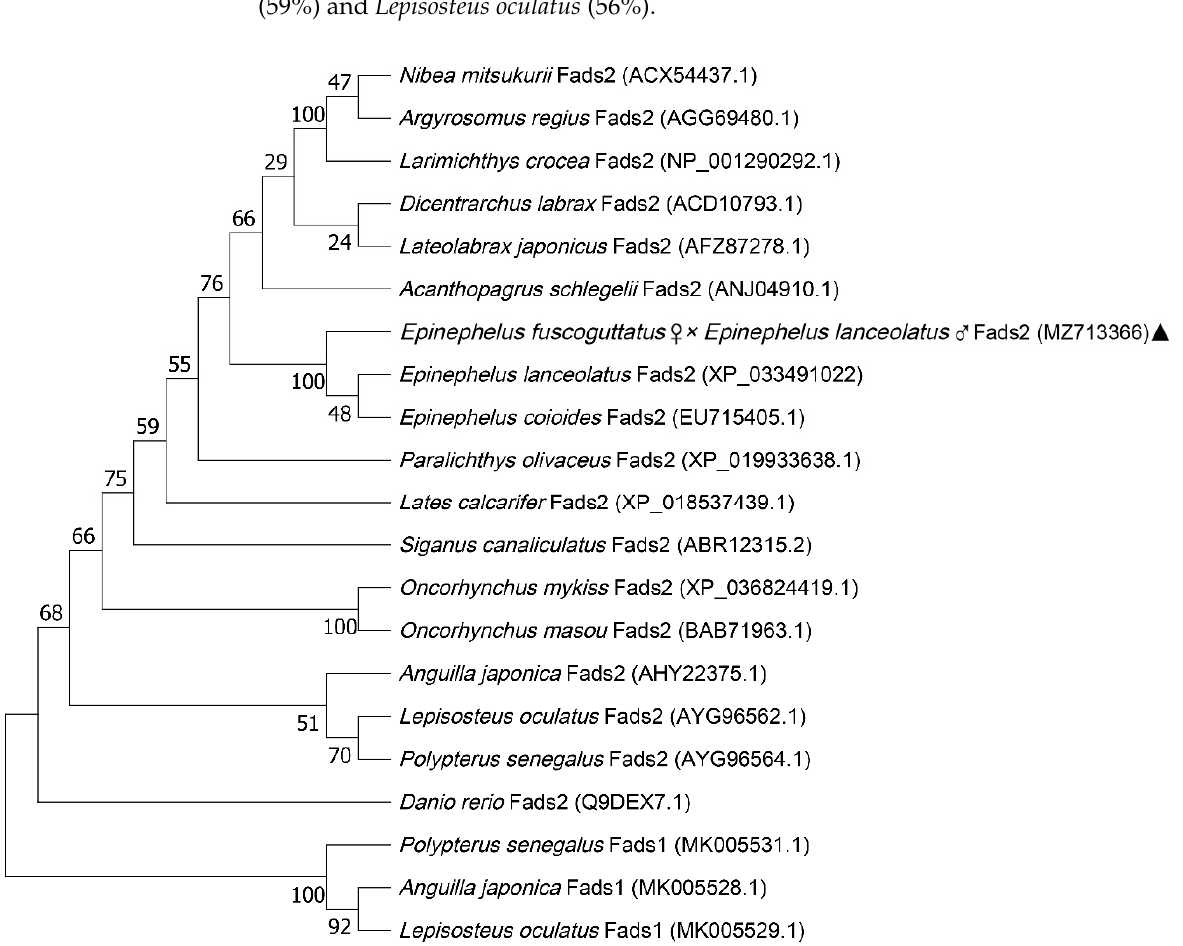
Figure 5. Phylogenetic tree analysis constructed by using full-length amino acid sequences of Fads2. The full-length amino acid sequence of Fads2 and Fads1 proteins were extracted from Genbank and analyzed using Maximum Likelihood method by Mega x with 1000 bootstrap replications. The numbers shown at branches indicated the bootstrap values (%). Fads1 is regarded as the outgroup. Our Epinephelus fuscoguttatus ♀ × Epinephelus lanceolatus ♂ sequence was marked “ ▲ ”.